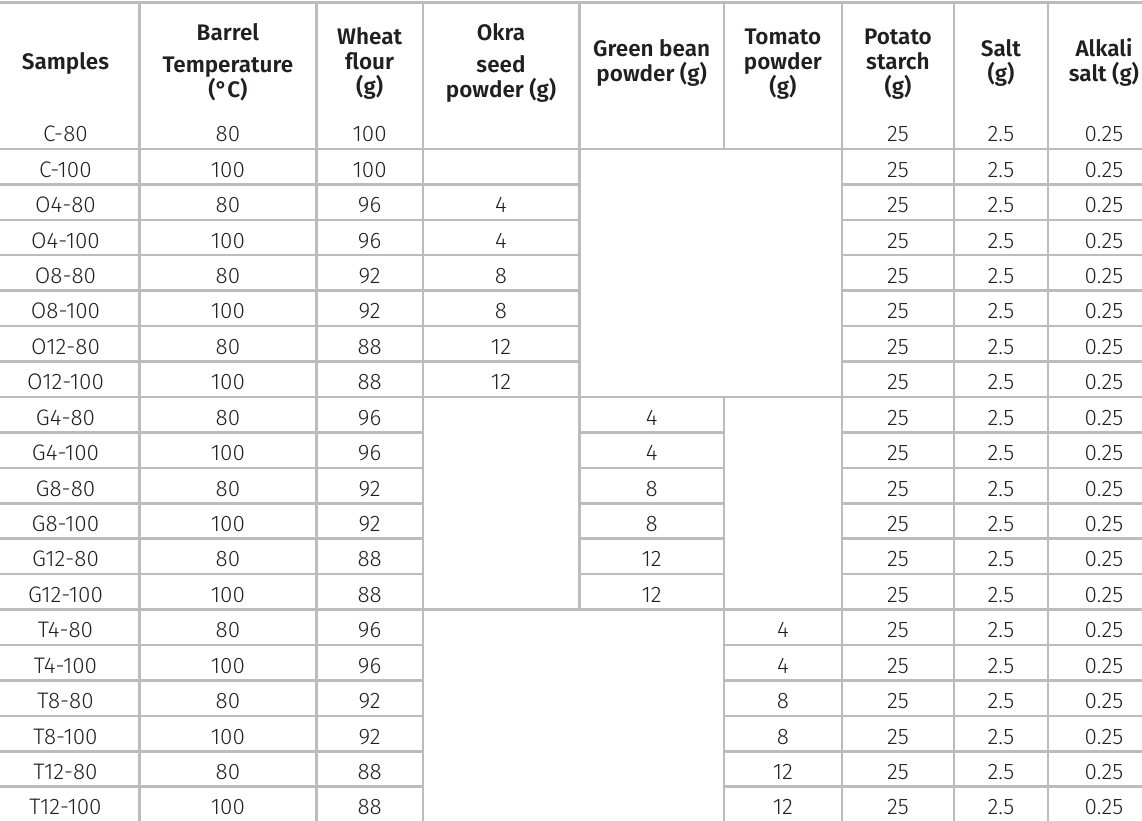
Table I. Compositions and codes of the products enriched with dried green bean, tomato, and okra seed powder.